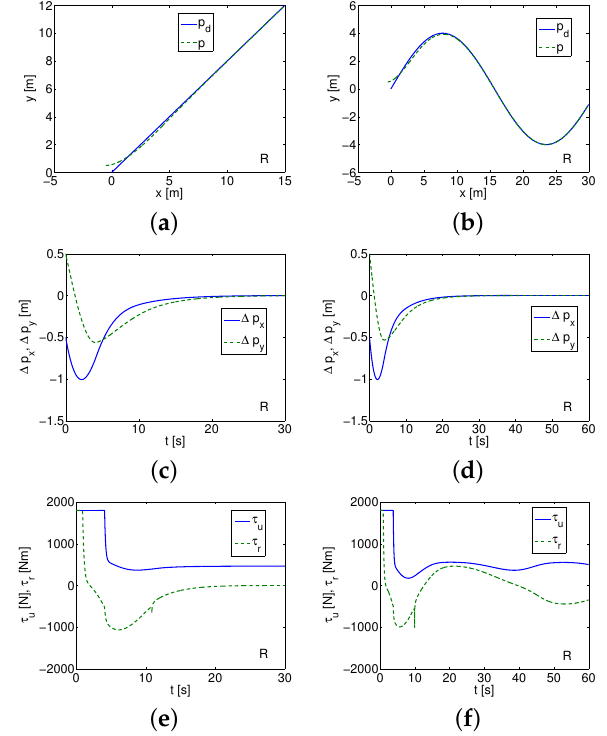
Figure 9. Simulation results for ROPOS (TSMC)—linear and sine trajectory. ( a , b ) Desired and realized trajectory; ( c , d ) position errors; ( e , f ) applied